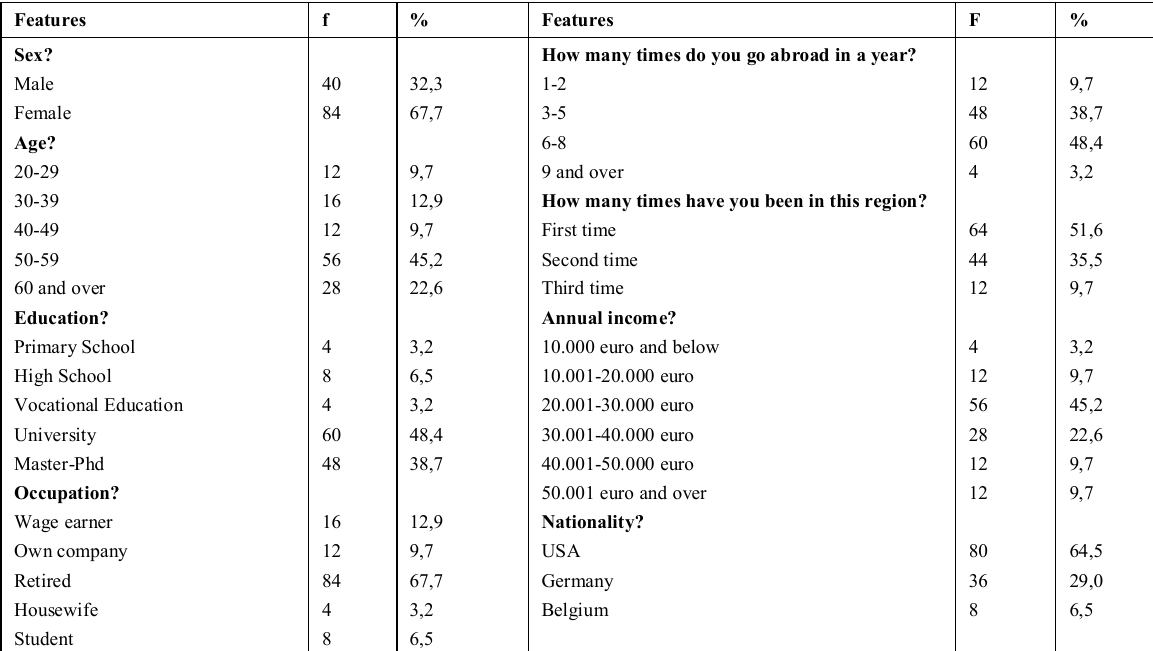
Table 1: Demographic